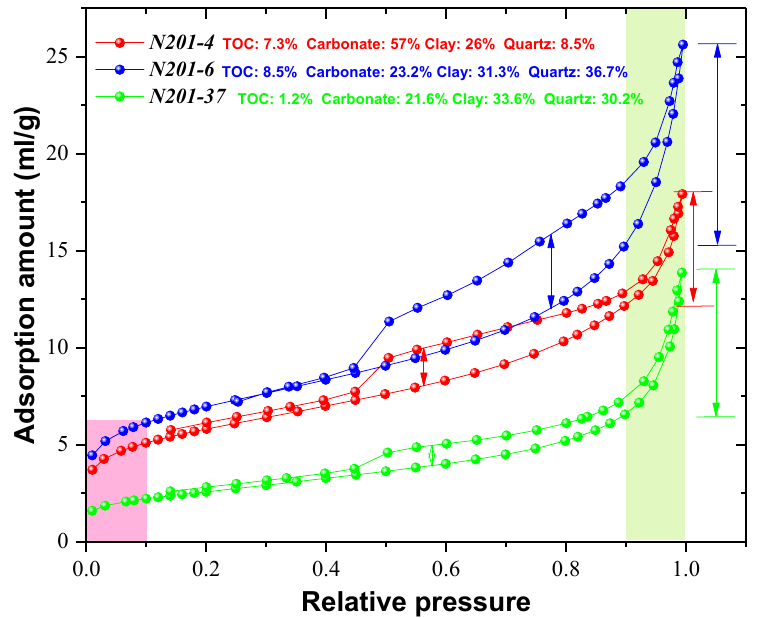
Figure 8. Representative adsorption and desorption isotherms among all the experimental N 2 adsorption data.